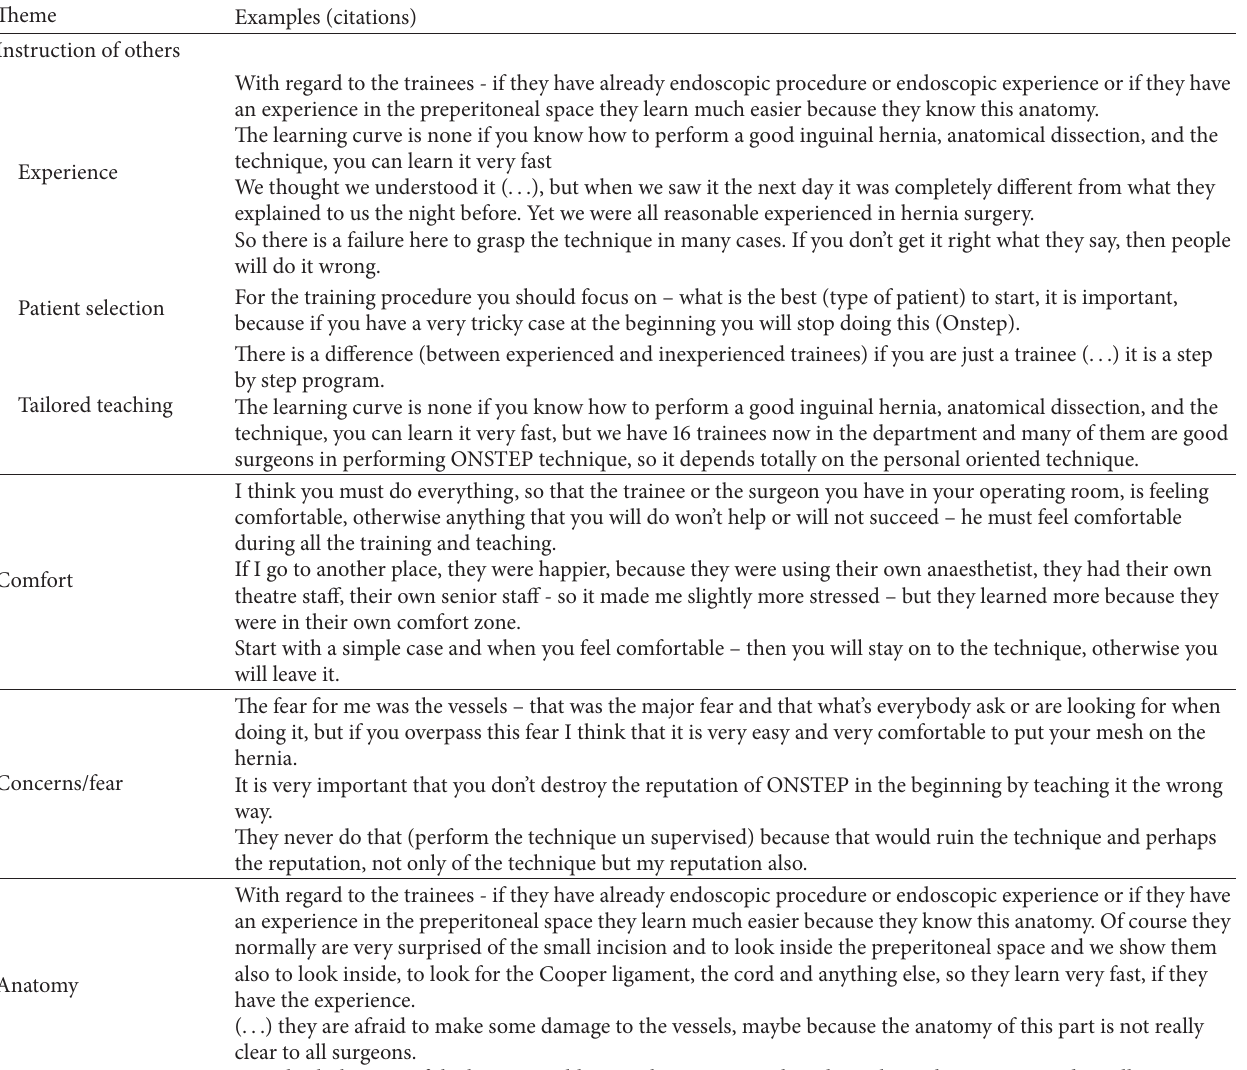
Table 2: Identified themes with examples from the